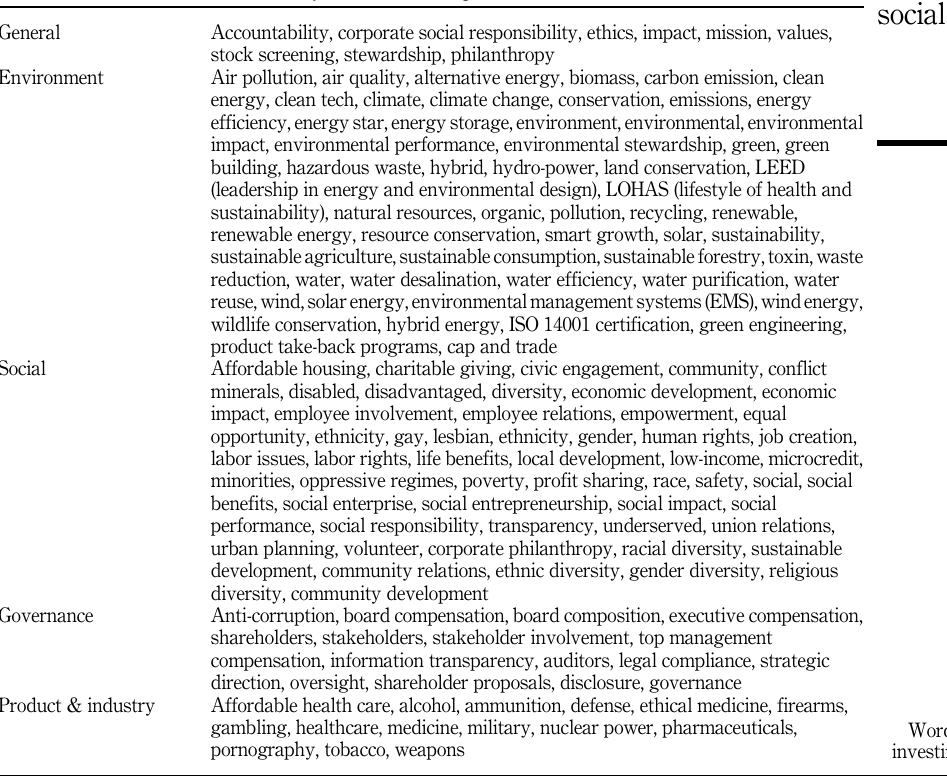
Table 1. Word list for social investing